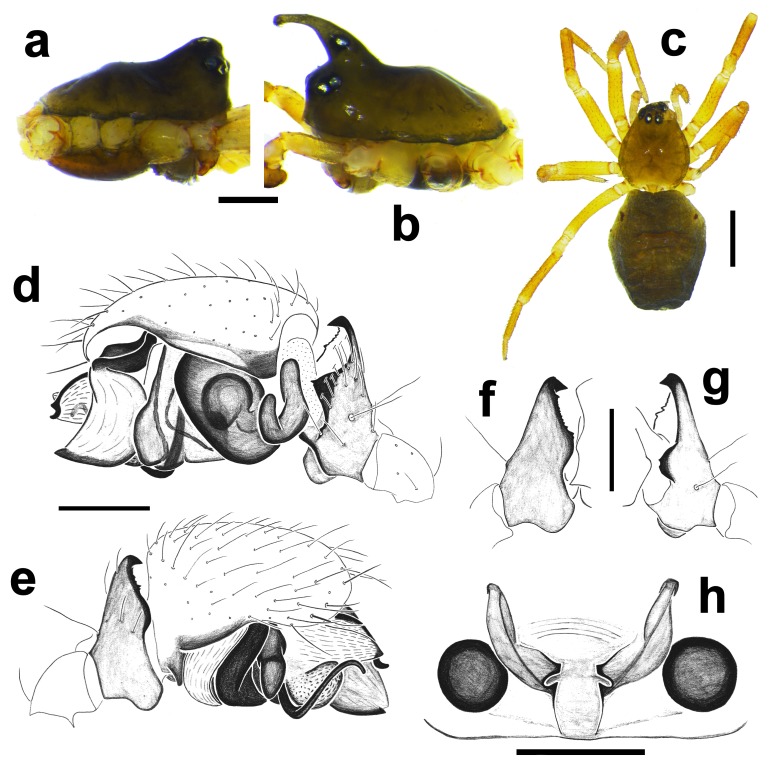
Metopobactrus
prominulus (O. Pickard-Cambridge, 1872). a: male from Ordesa, lateral habitus, scale = 0.2 mm; b: male from Picos de Europa, lateral habitus, scale = 0.2 mm; c: female from Picos de Europa, dorsal habitus, scale = 0.5 mm; d: male from Ordesa, left palp, retrolateral, scale = 0.1 mm; d: male from Ordesa, left palp, prolateral, scale = 0.1 mm; e: male from Picos de Europa, left tibia, prolateral, scale = 0.1 mm; f: male from Picos de Europa, left tibia, retrolateral, scale = 0.1 mm; g: female from Picos de Europa, epigynum, ventral, scale = 0.1 mm.